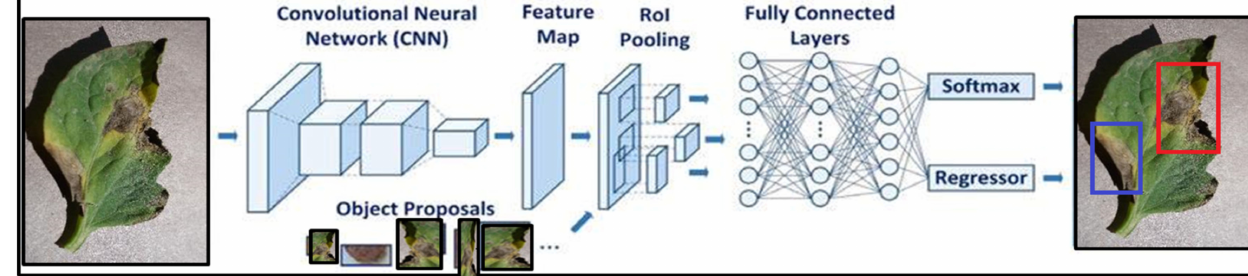
Figure 1. Fast R-CNN architecture.